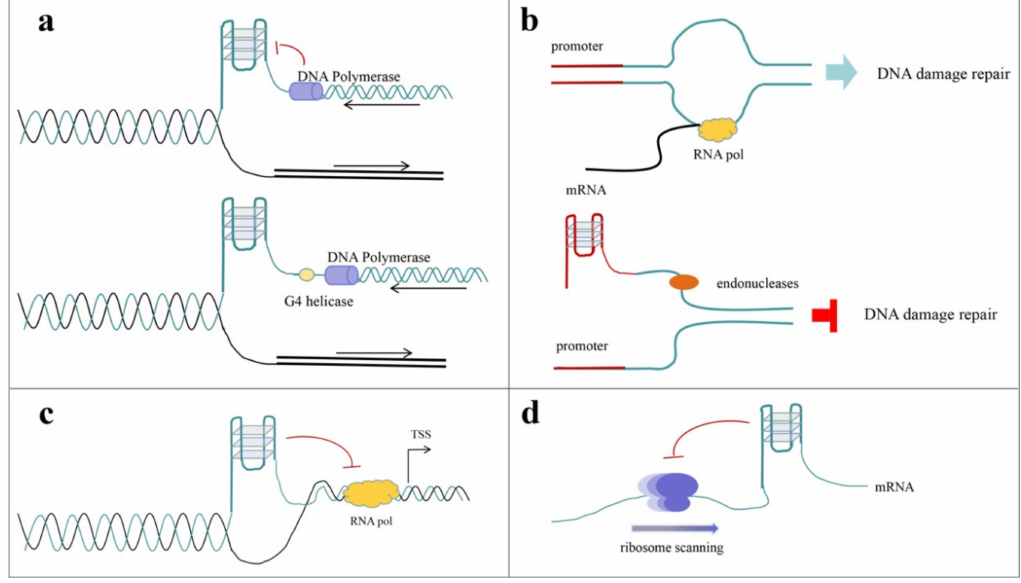
Figure 3. Schematic diagram of the possible role of G-quadruplexes in several cellular events. ( a ) G-quadruplexes block the replication process, and G4 helicase could withstand this inhibition. ( b ) G-quadruplexes forming in the promoter regions could interfere with the DNA damage response. ( c ) G-quadruplexes upstream of the TSS could inhibit the transcription process. ( d ) G-quadruplexes could also interfere with the ribosome scanning process and thus inhibit protein